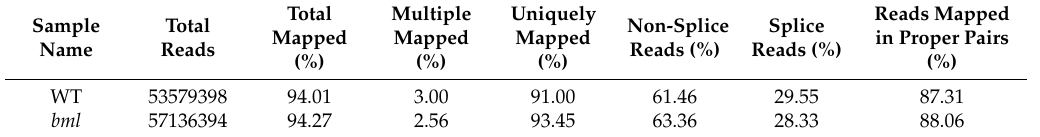
Table 2. Alignment statistics summary of RNA-seq and mapping